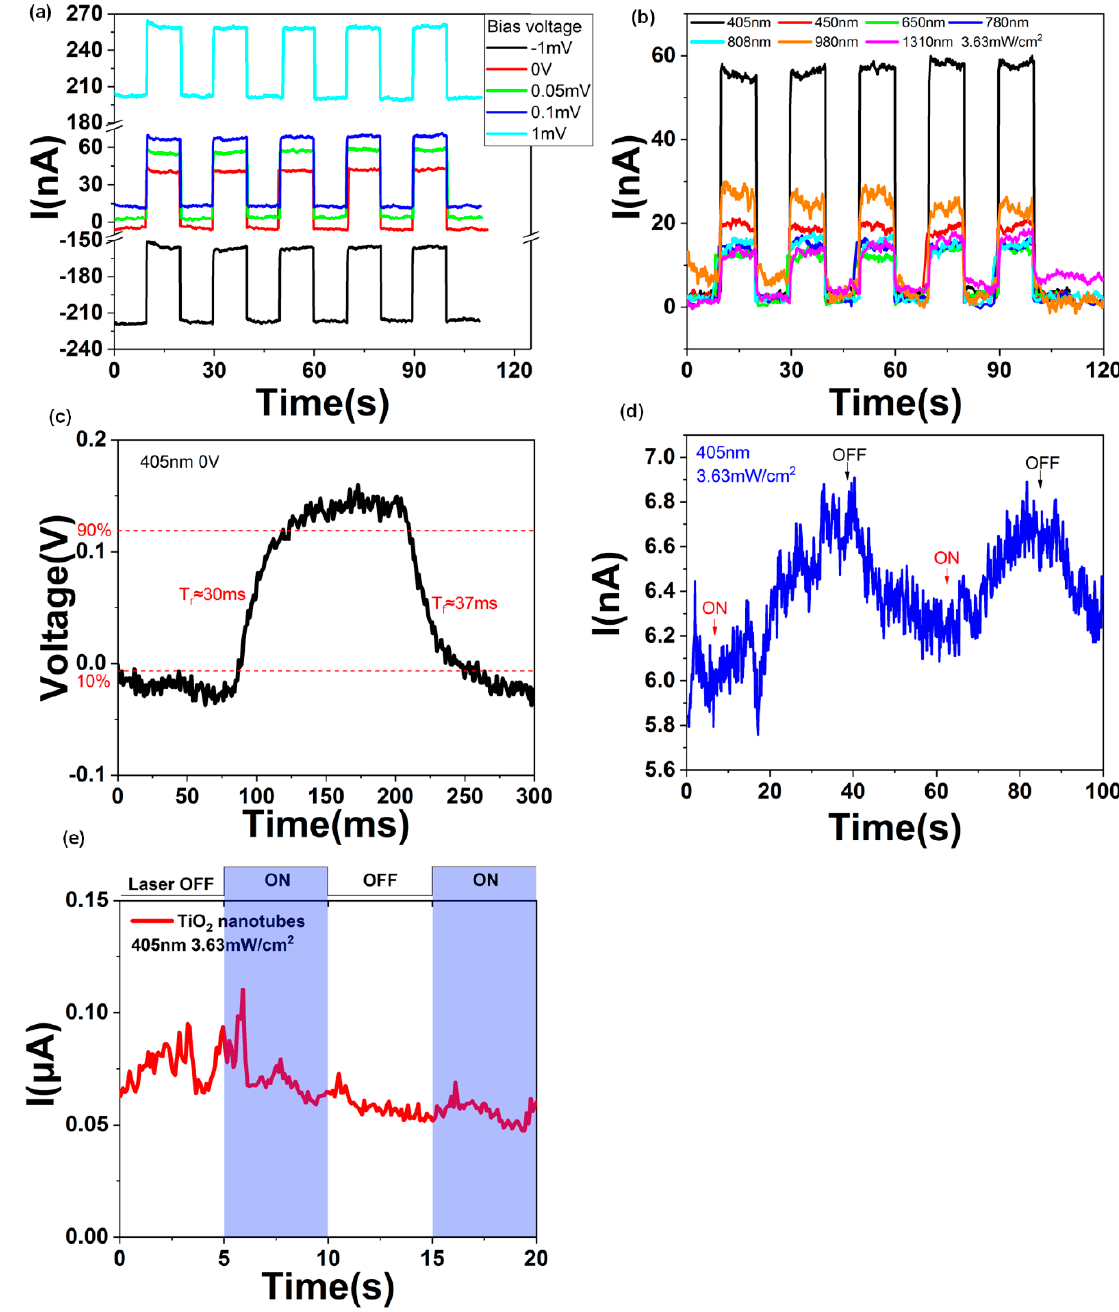
Figure 2. ( a ) Current and time curves with different bias voltage under 405 nm laser irradiating of the TiO 2 nanotubes/graphene device. ( b ) Current and time curves under different laser irradiating of the TiO 2 nanotubes/graphene device. ( c ) The response time of the graphene/TiO 2 nanotubes photodetector under 405 nm laser irradiating without bias of the TiO 2 nanotubes/graphene device. ( d ) Current and time curves of monolayer graphene on SiO 2 /Si under 405 nm laser irradiating. ( e ) Current and time curves of TiO 2 nanotubes without graphene on it under 405 nm laser irradiating. The bias voltage is 0.2V.